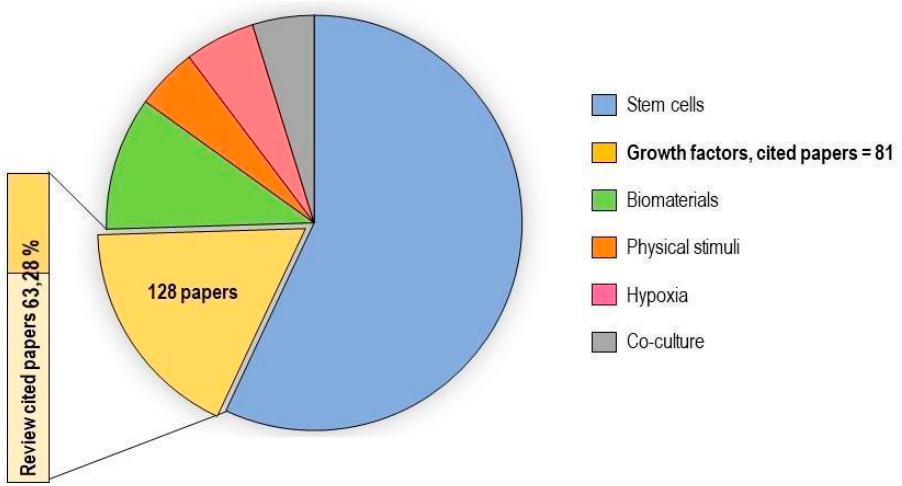
Figure 10. The yellow section shows the percentage / number of papers available on the Scopus database obtained by combining key words in vitro stem cells tendon di ff erentiation with growth factors. In the histogram, the relative percentage of cited papers is expressed as well as the relative number in the legend.